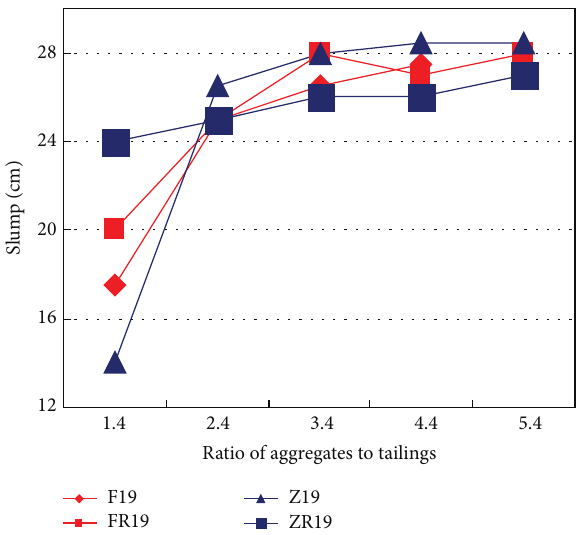
Figure 5: 14-day backfill UCS using 12% cement replacement.